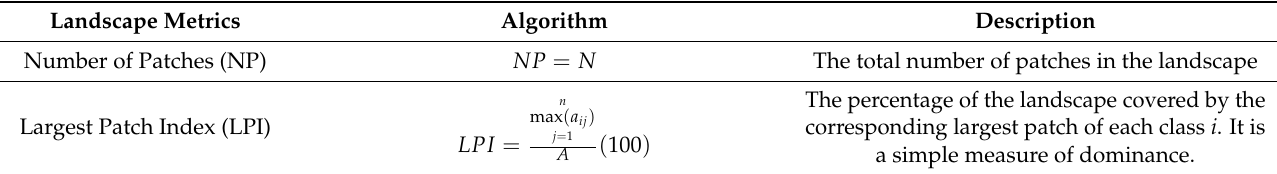
Table 2. Landscape metrics used in this